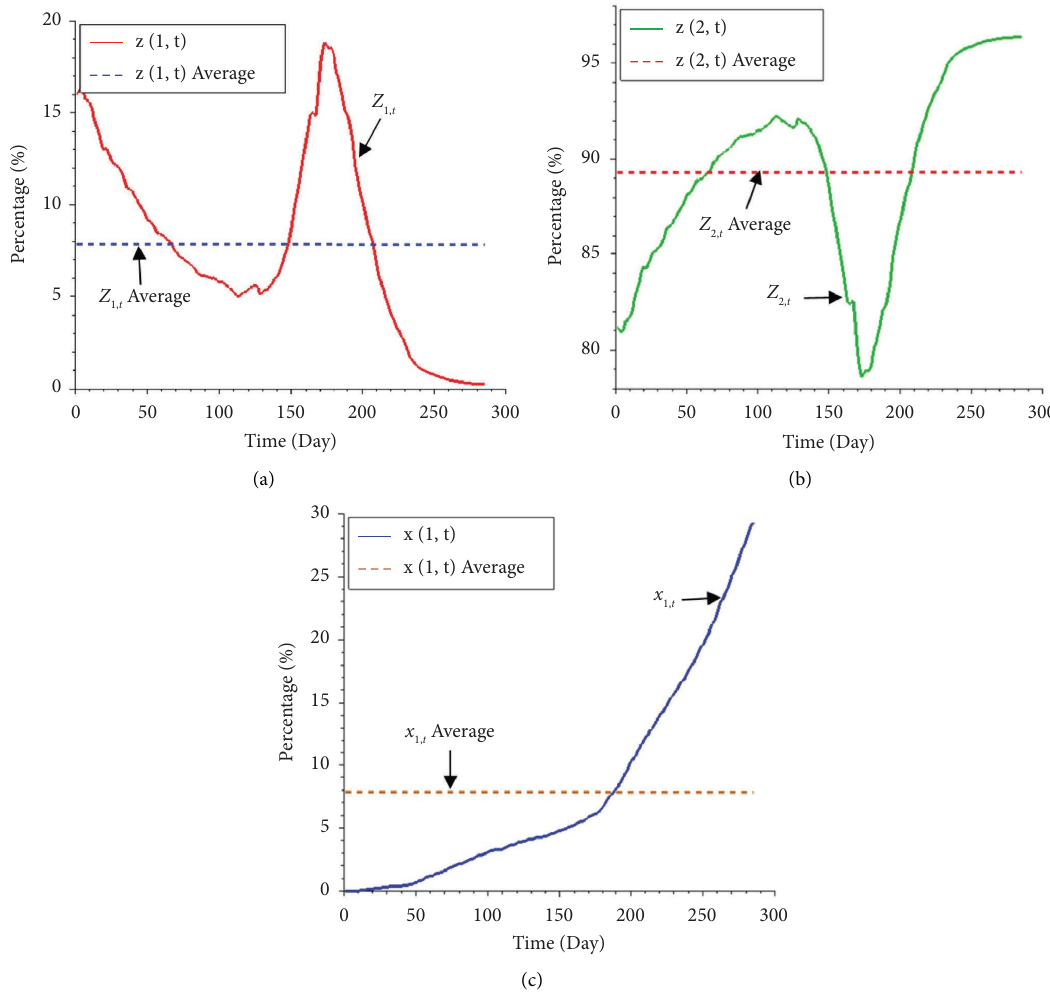
Figure 1: Graph of z